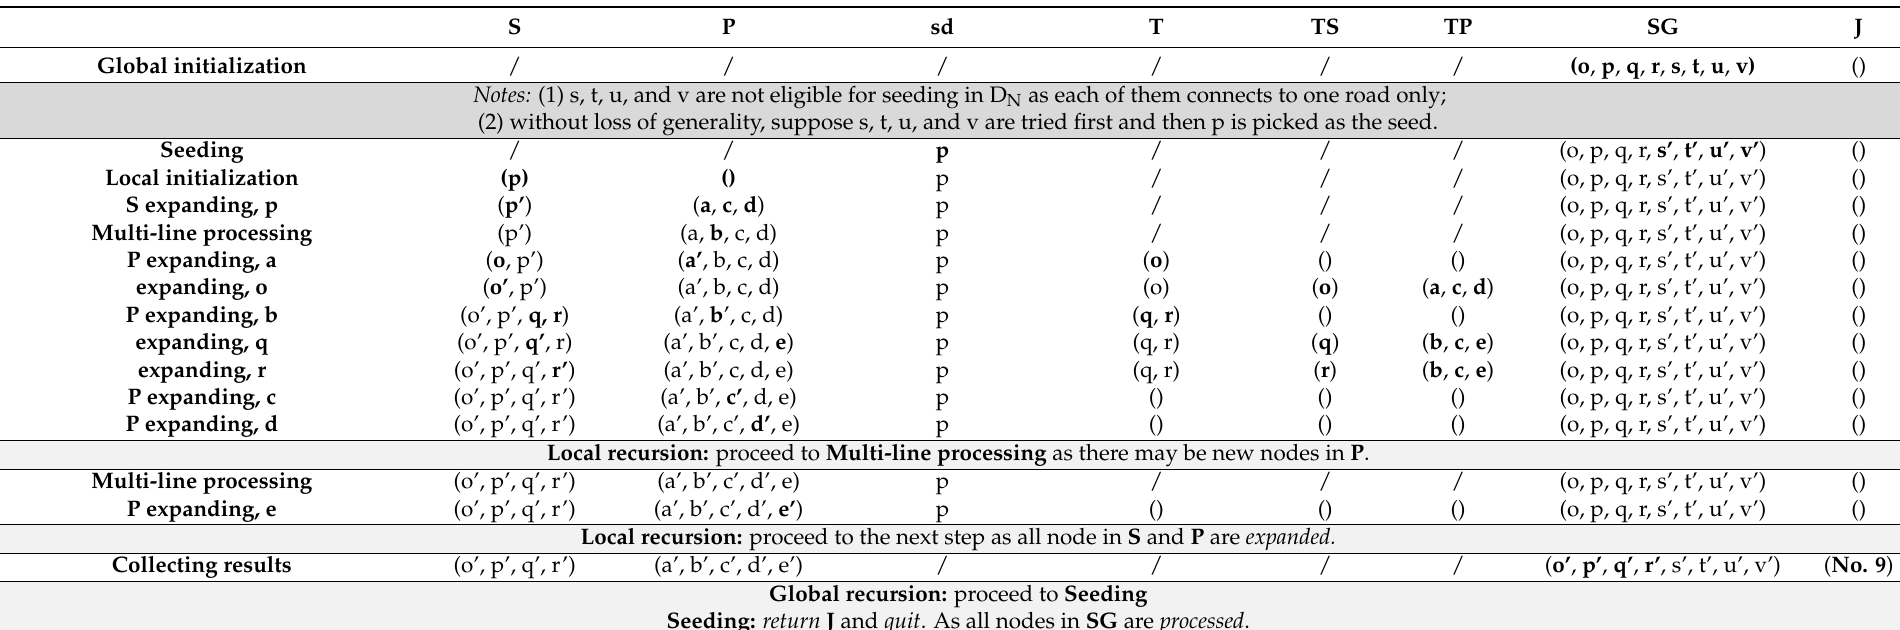
Table 1. The steps and states of the algorithm in identifying complex junction No.9 in D N (the changed states are in bold in each step). S P